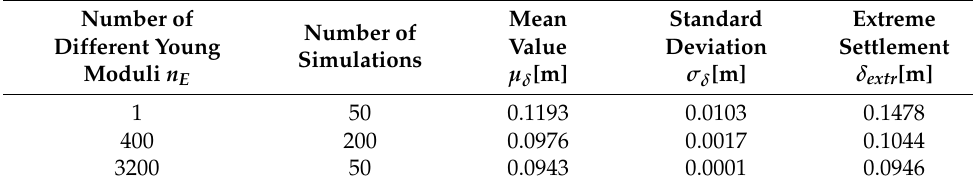
Table 3. Strip foundation settlement parameters; the Monte Carlo FE material model.